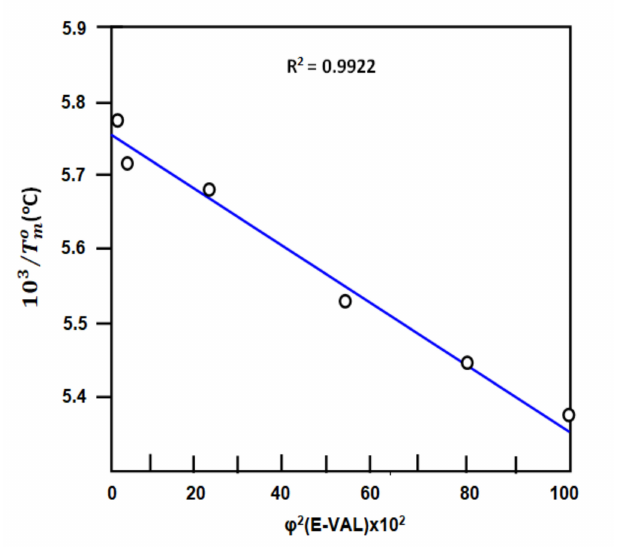
Figure 4. Variation of the inverse of T o m vs. the square of ϕ E − VAL in the